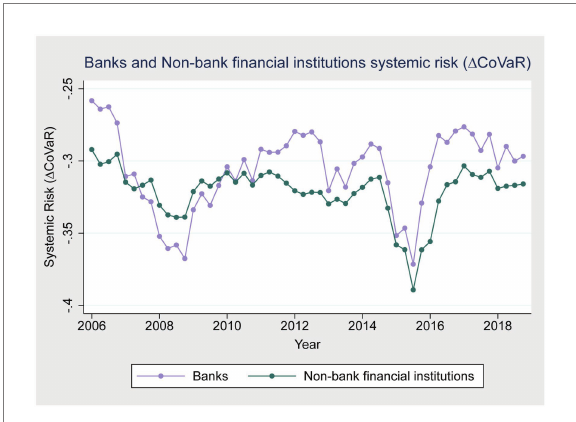
FIGURE 1 Banks and non-bank financial institutions systemic risk.